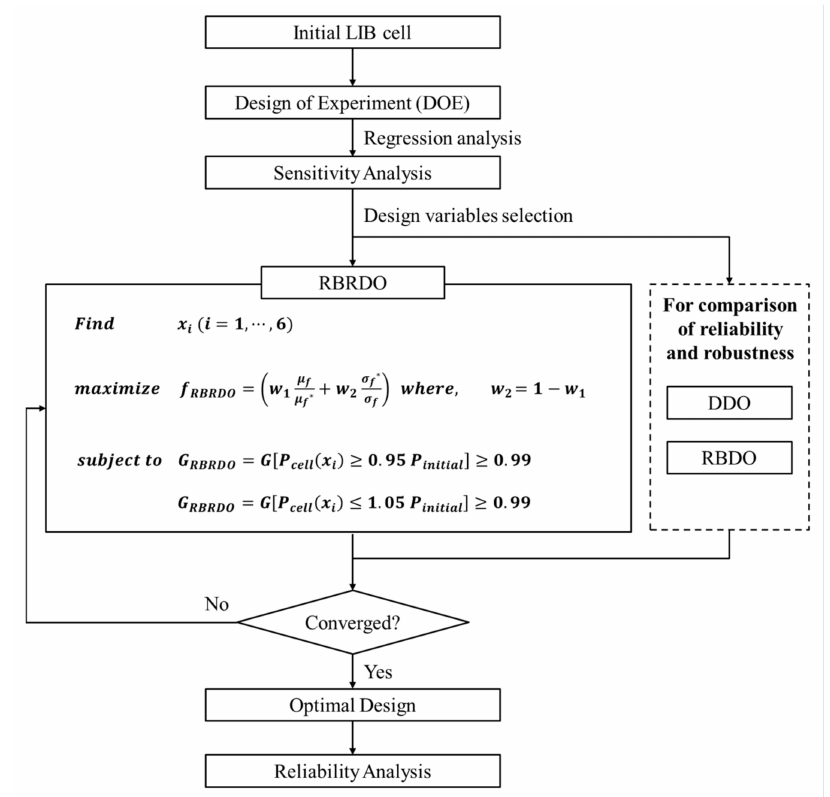
Figure 4. Flowchart of the RBRDO process.